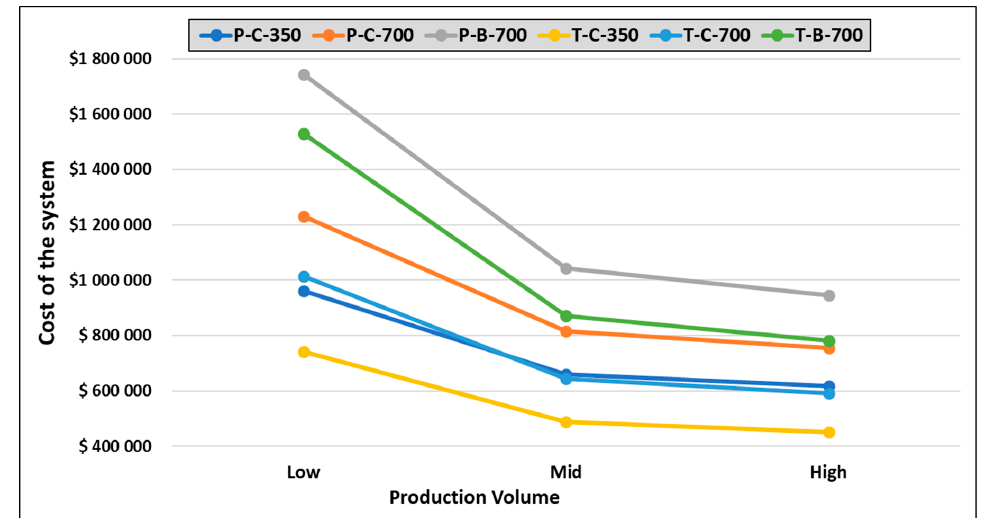
Figure 11. HDRSAM Anlysis: Comparison of the investment cost of the systems. In the legend, the letters and numbers (from left to right) refer to the type of hydrogen delivery option (P = pipeline, T = Tube trailer), type of dispensing (C = cascade dispensing, B = booster dispensing) and dispensing option (350 or 700 bar)).